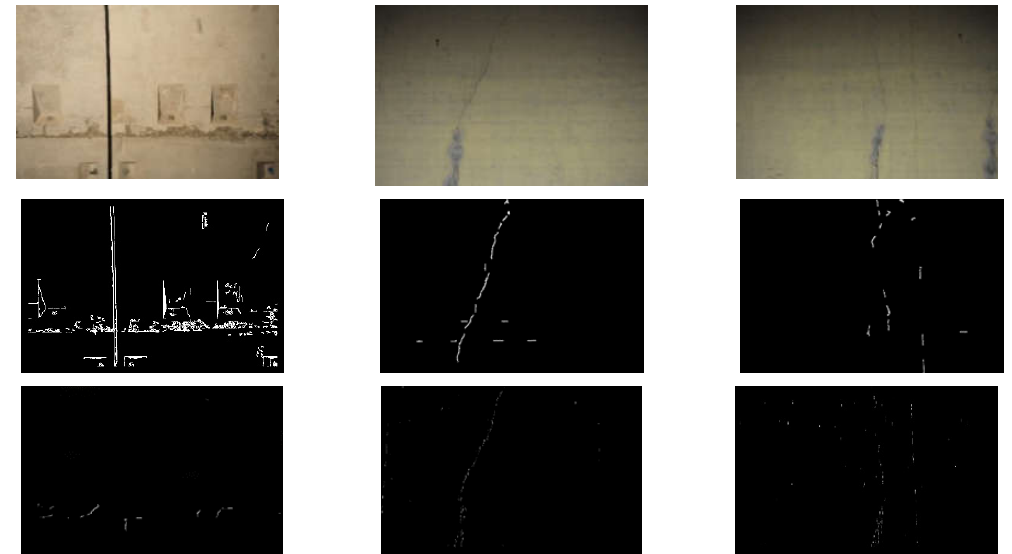
Figure 6. Comparative illustration of the outputs. Top row shows the original images, middle row the image processing results and bottom row the CNN